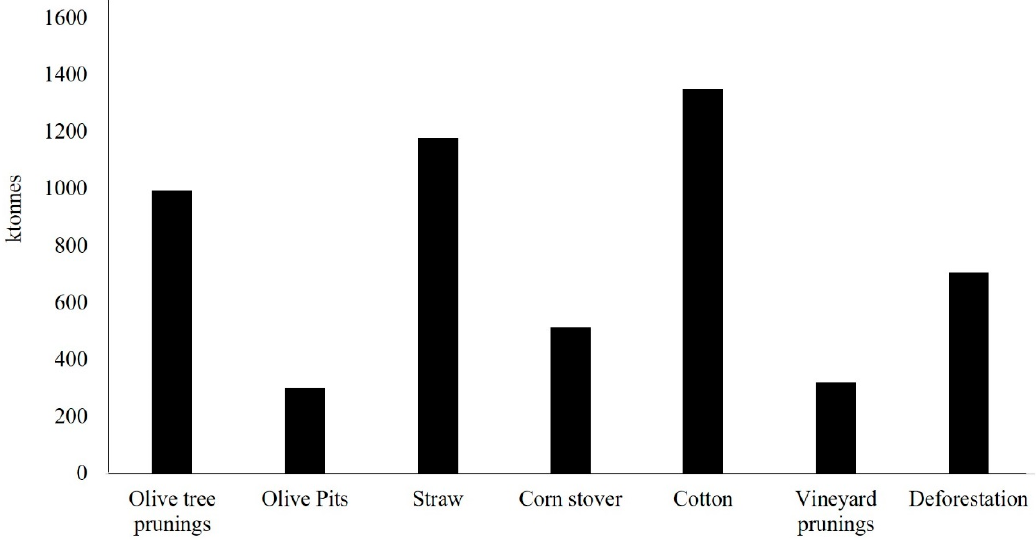
Figure 3. Distribution of annual biomass production, in tonnes, by agricultural waste category in Greece [15].